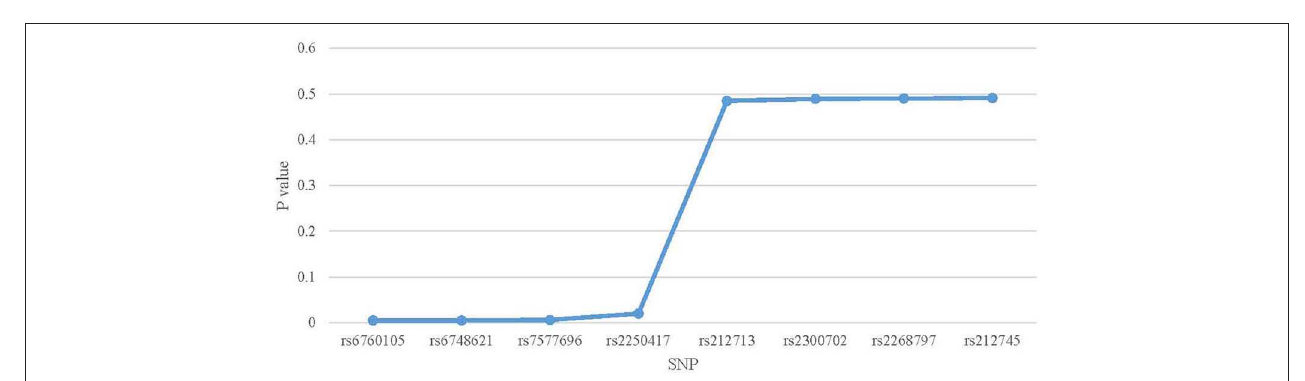
FIGURE 3 | Scatter plot of the P -values in leave-one-out